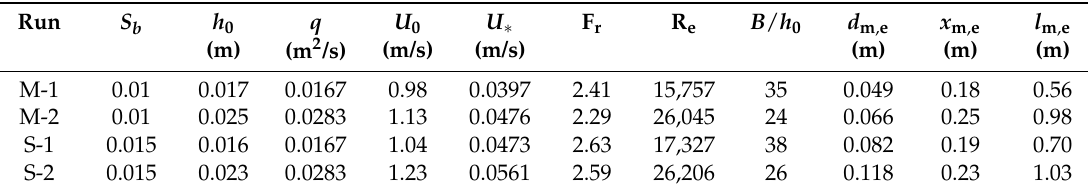
Table 1. Summary of the experimental conditions.